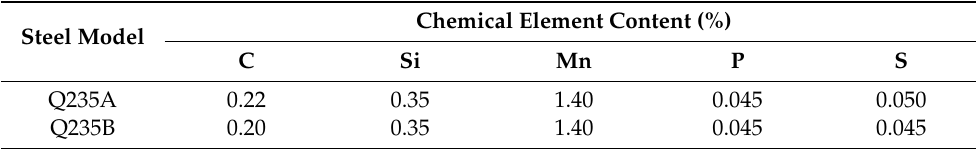
Table 1. Mass fraction of Q235 chemical